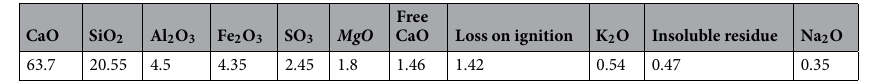
Table 2. The chemical characteristics of cement (wt %).